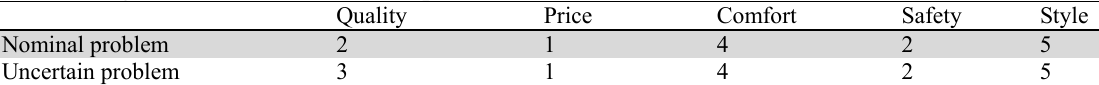
The ranking of each criterion in example 2 Quality Price